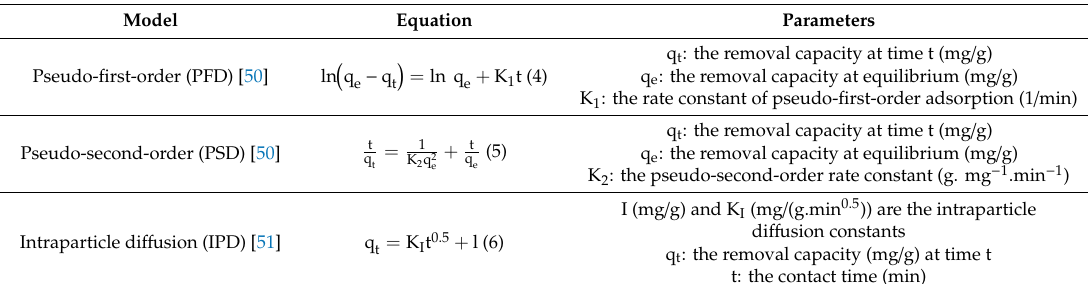
Table 2. Kinetic model equations.